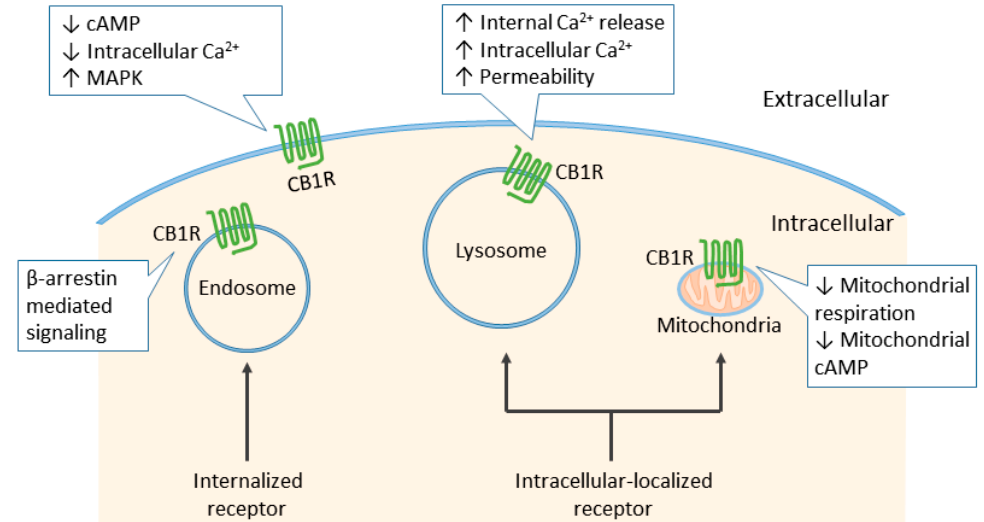
Figure 3. Subcellular localization of the CB1R. Typically, the CB1R is located at cell surface and inhibits cyclic adenosine monophosphate (cAMP) formation and calcium influx upon activation. Constitutive and ligand-induced internalized CB1Rs mediate signaling pathways through β -arrestin. Intracellular-localized CB1Rs do not translocate to plasma membrane. Instead, they form a subpopulation with pharmacological properties distinct from their plasma membrane-localized counterparts. CB1Rs located on lysosomes can increase intracellular calcium concentrations through the release of internal calcium stores, and increase the permeability of lysosomes. Mitochondrial